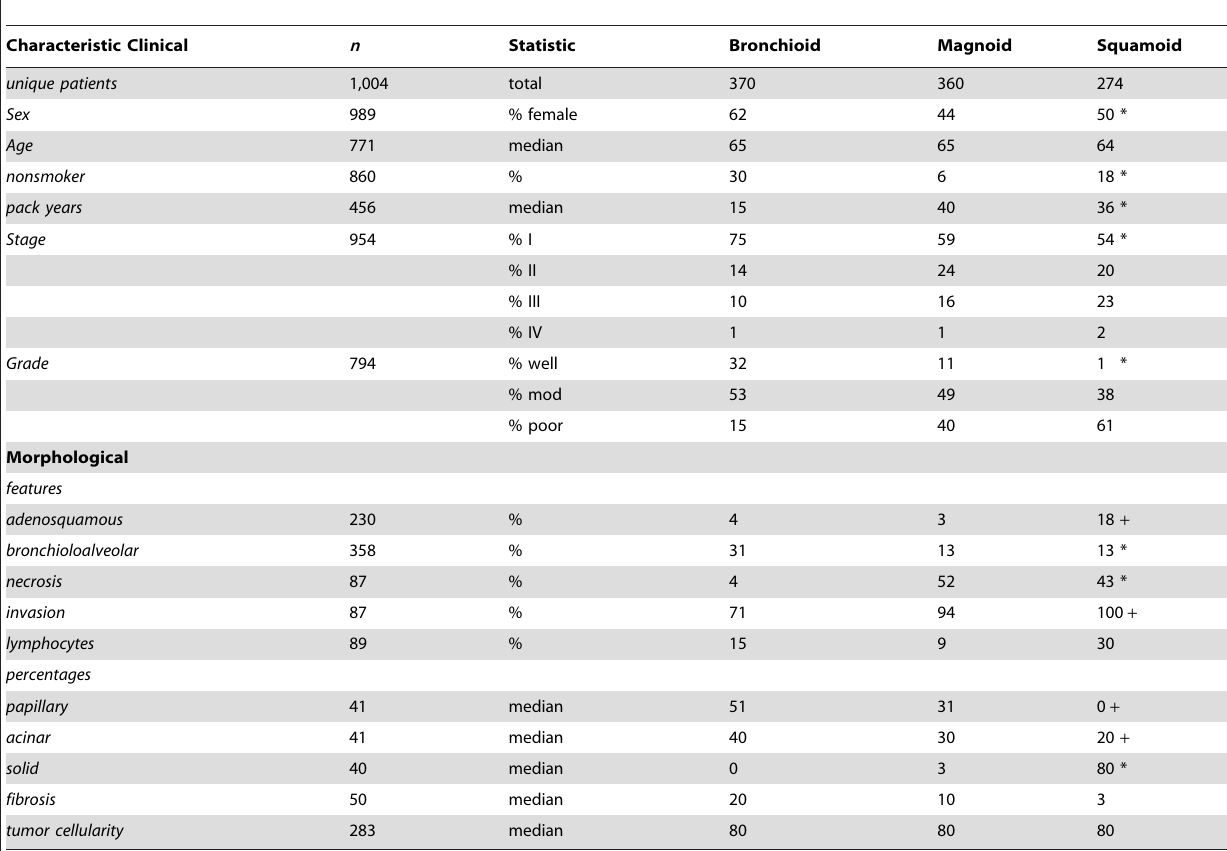
Table 1: Subtype clinical and morphological